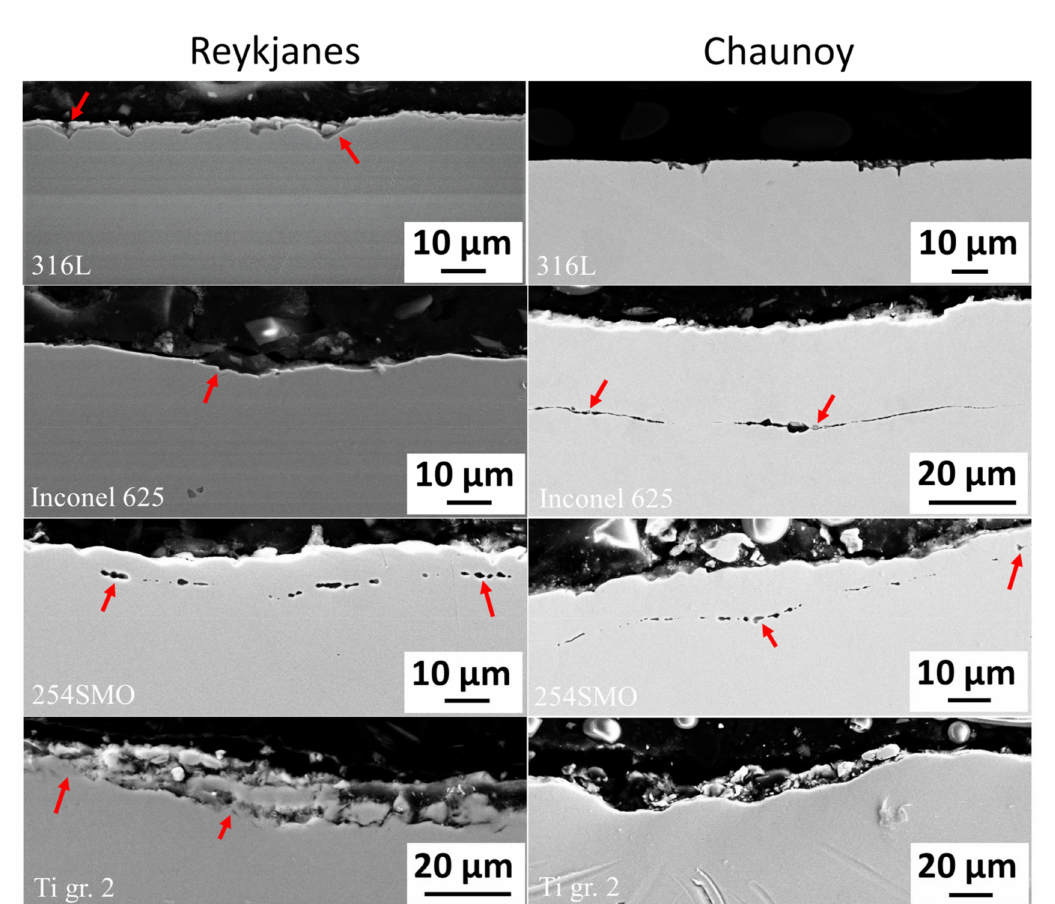
Figure 8. Scanning Electron Microscope (SEM) cross-section images taken of the most affected areas detected after exposure in both locations. The arrows indicate areas of interest: corrosion layer for 316L (Reykjanes), subsurface cracks for Inconel 625 (Chaunoy) and 254SMO (Chaunoy and Reykjanes), and abrasion of Ti gr. 2 surfaces (Chaunoy and